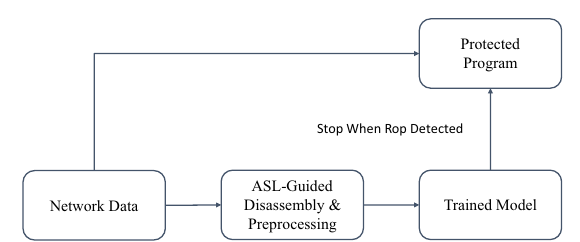
Fig. 2 The flow diagram of DeepReturn in production